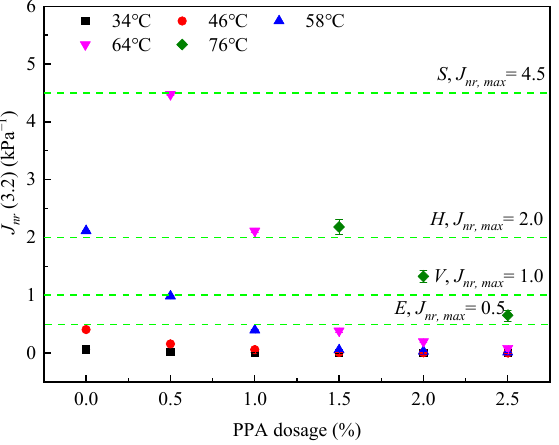
Figure 7. Appropriate tra ffi c levels for PPA − modi fi ed asphalt binders.